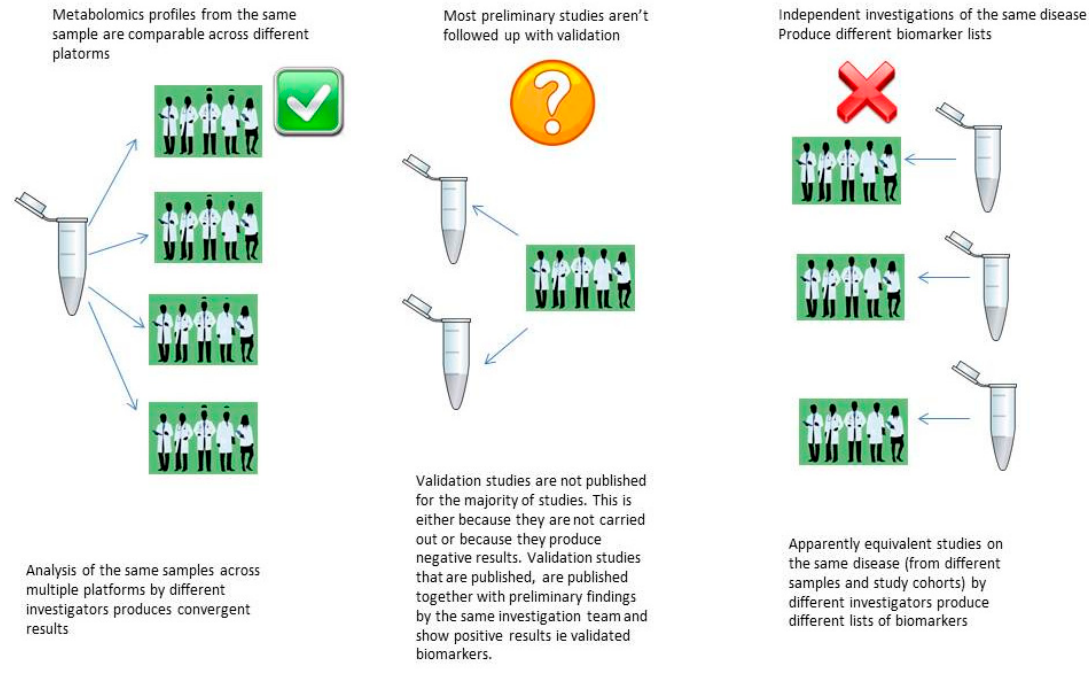
Figure 1. Can result irreproducibility in metabolomics be explained by contextual